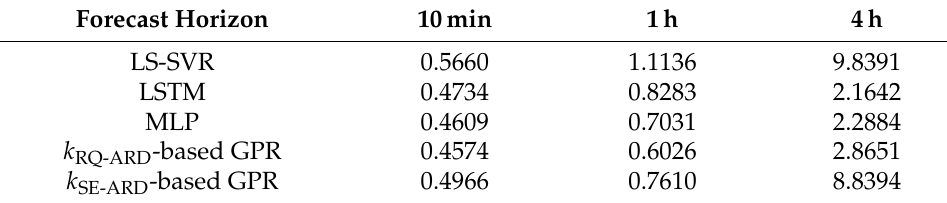
Table 4. CWC values (lower is better) for all the models included in the comparative